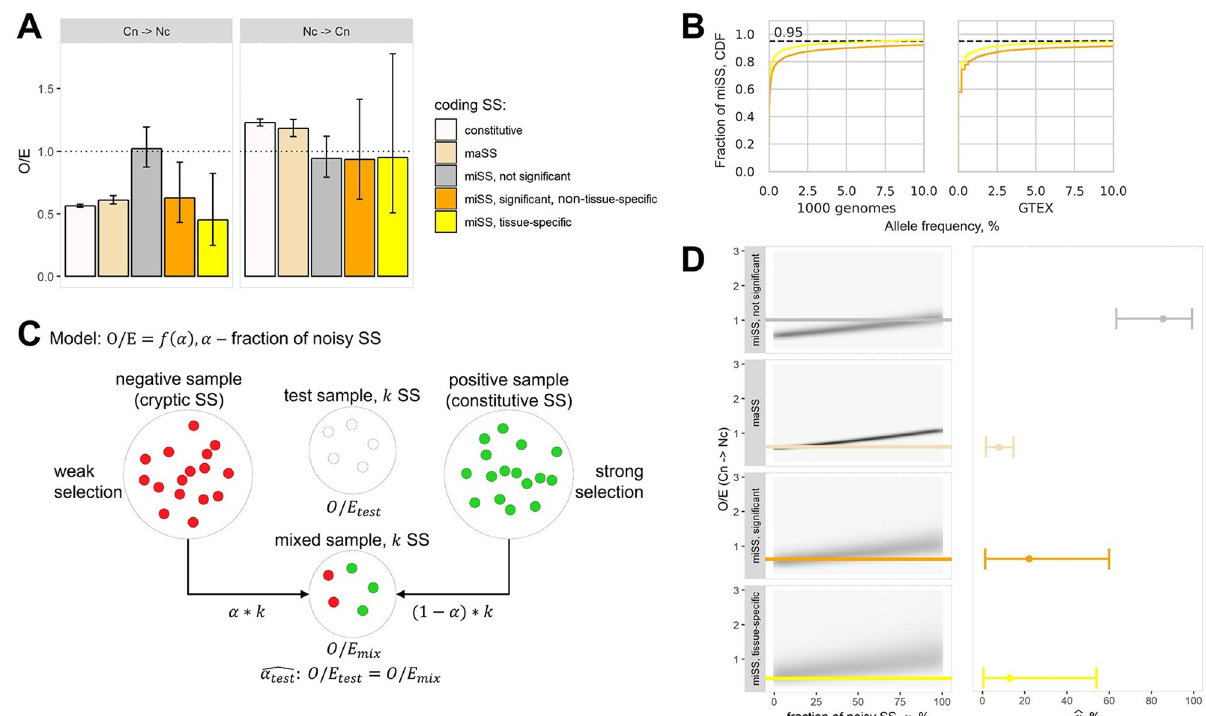
Fig 6. Evolutionary selection of miSS. (A) The strength of the selection, defined as the ratio of the observed ( O ) to the expected ( E ) number of substitutions, in selected categories of splice sites in the coding regions. The neutral expectation ( O / E = 1) is marked by a dashed line. The error bars denote confidence intervals for the ratio of two binomial proportions based on likelihood scores [64]. (B) The cumulative distribution of allele frequencies of SNPs in splice site consensus sequences and in 35-nt exonic regions adjacent to splice sites from GTEx and 1000 Genomes projects. (C) The mixture model for the estimation of the fraction of noisy splice sites ( α ) using O / E ratio. A test sample of size k is modelled as a mixture of α k purely noisy (cryptic) splice sites and (1 − α ) k purely functional constitutive splice sites. (D) The estimation of the fraction of noisy splice sites ( α ) from the observed values of O / E . Bootstrapped joint distribution of O / E and α values (left). 2.5%, 50% and 97.5% quantiles of the estimated α (right).